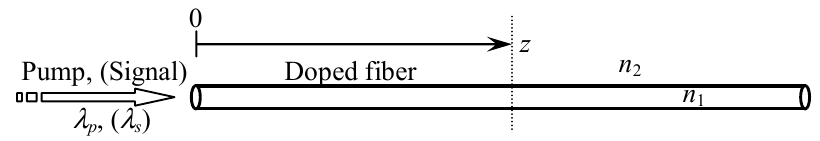
Figure 2. Setup for the calculation of the light power P ( t , z , λ ) as it propagates in a doped polymer optical fiber (POF) pumped longitudinally. No mirrors are